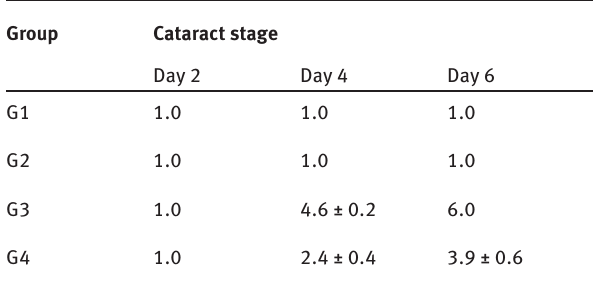
Table 1: Effect of hesperetin to cataract stage in lens of selenite- induced cataract